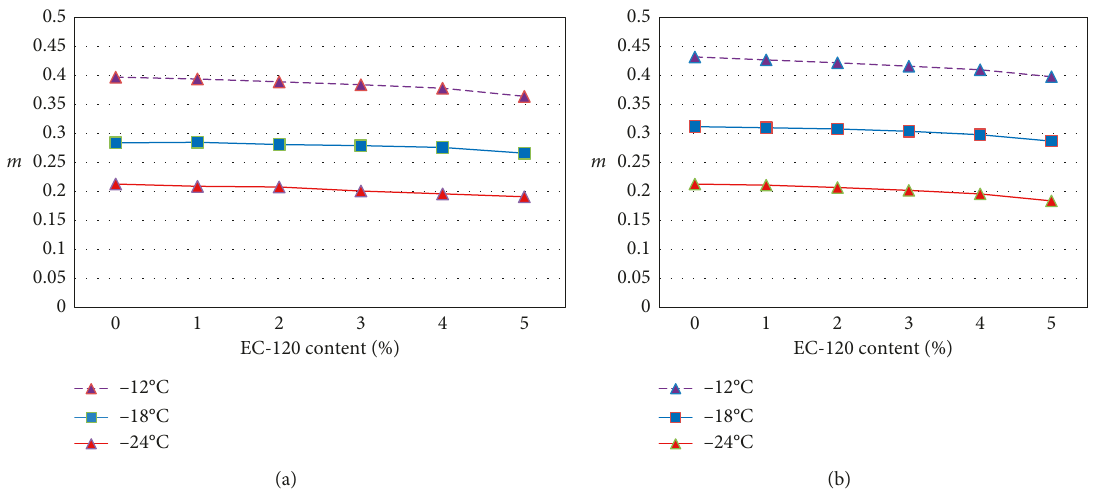
Figure 3: Relationships between m of WMA binders and EC-120 content. (a) Warm-mixed matrix asphalt A-70. (b) Warm-mixed SBS